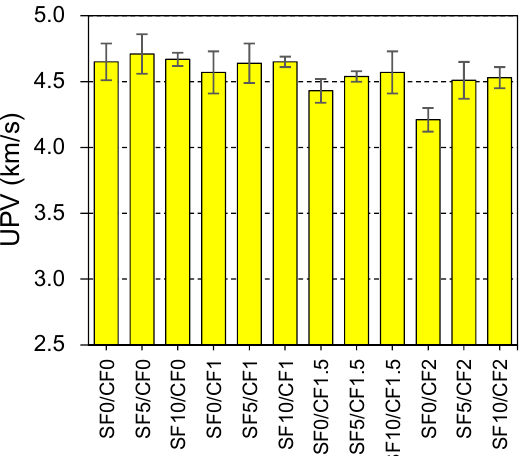
Figure 13. Effect of silica fume and coir reinforcement on the ultrasonic pulse velocity (UPV) of HSC. A decline in the UPV value of HSC was noticed with the increasing coir